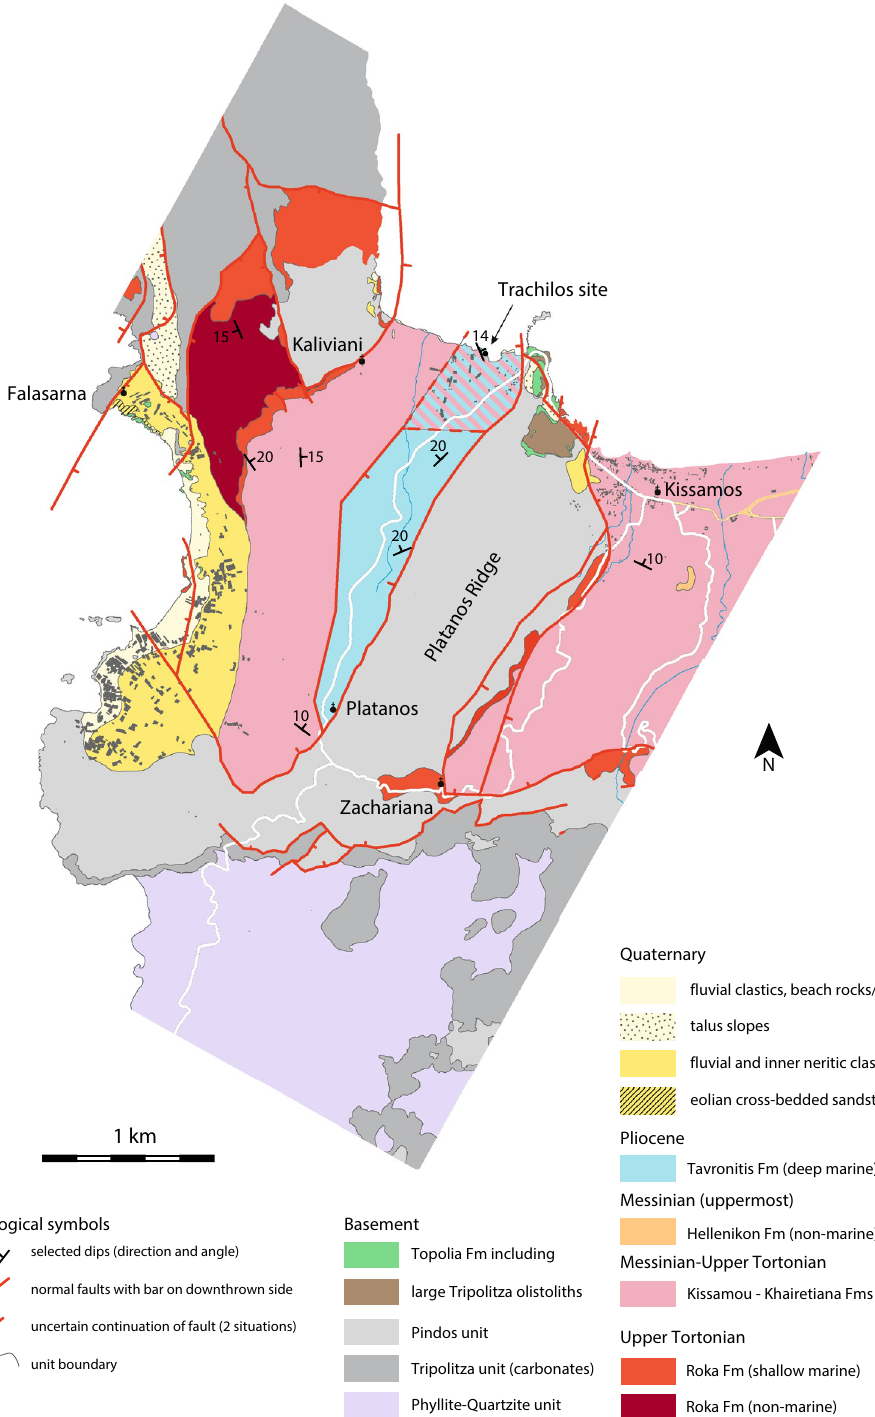
Figure 3. Geological map of the greater area around the Trachilos site (this study). Original map was digitized on Google Earth and based on a large number of GPS fixed field observations. The map shown is constructed from the data digitized in Google Earth and projected on OpenStreetMap topographical data using MaPublisher software (https:// www. avenza. com/ mapub lisher/). Pink/blue shading encloses the area of Pliocene (blue) or Messinian deposits (pink) dependent on the fault geometry (see